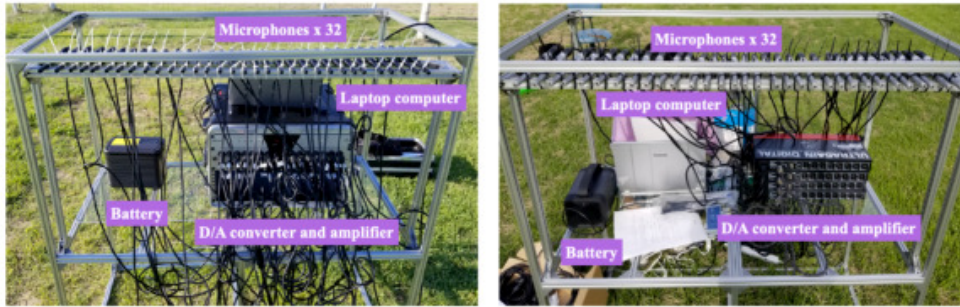
Figure 5. Photographs showing the appearance of M1 ( left ) and M2 ( right ) after the setup.